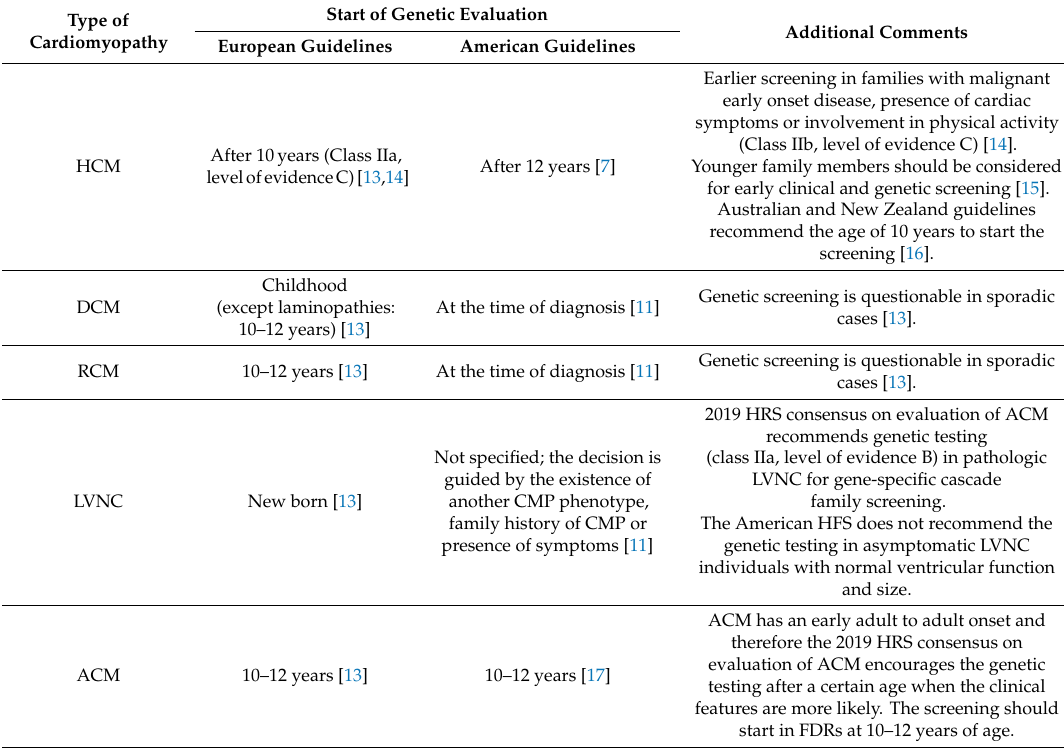
Table 1. Genetic screening of patients with